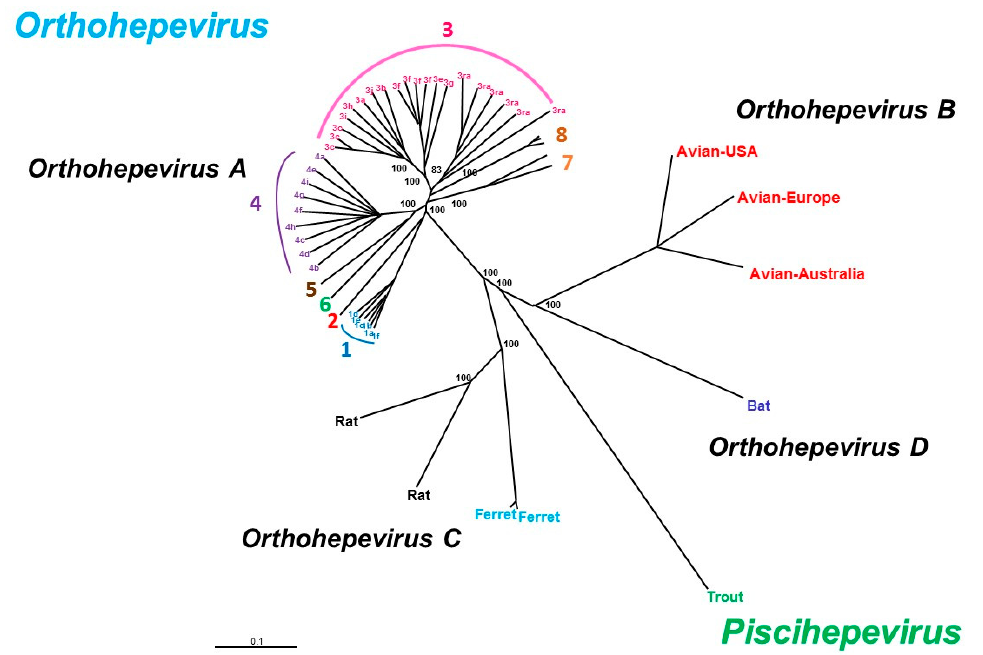
Figure 2. Phylogenetic tree based on full-length sequences of HEV strains. Sequence alignment was performed using ClustalW (MEGA5) and BioEdit, version 7.0. The neighbor-joining method was used to create the phylogenetic tree, with a bootstrap of 100 replicates.